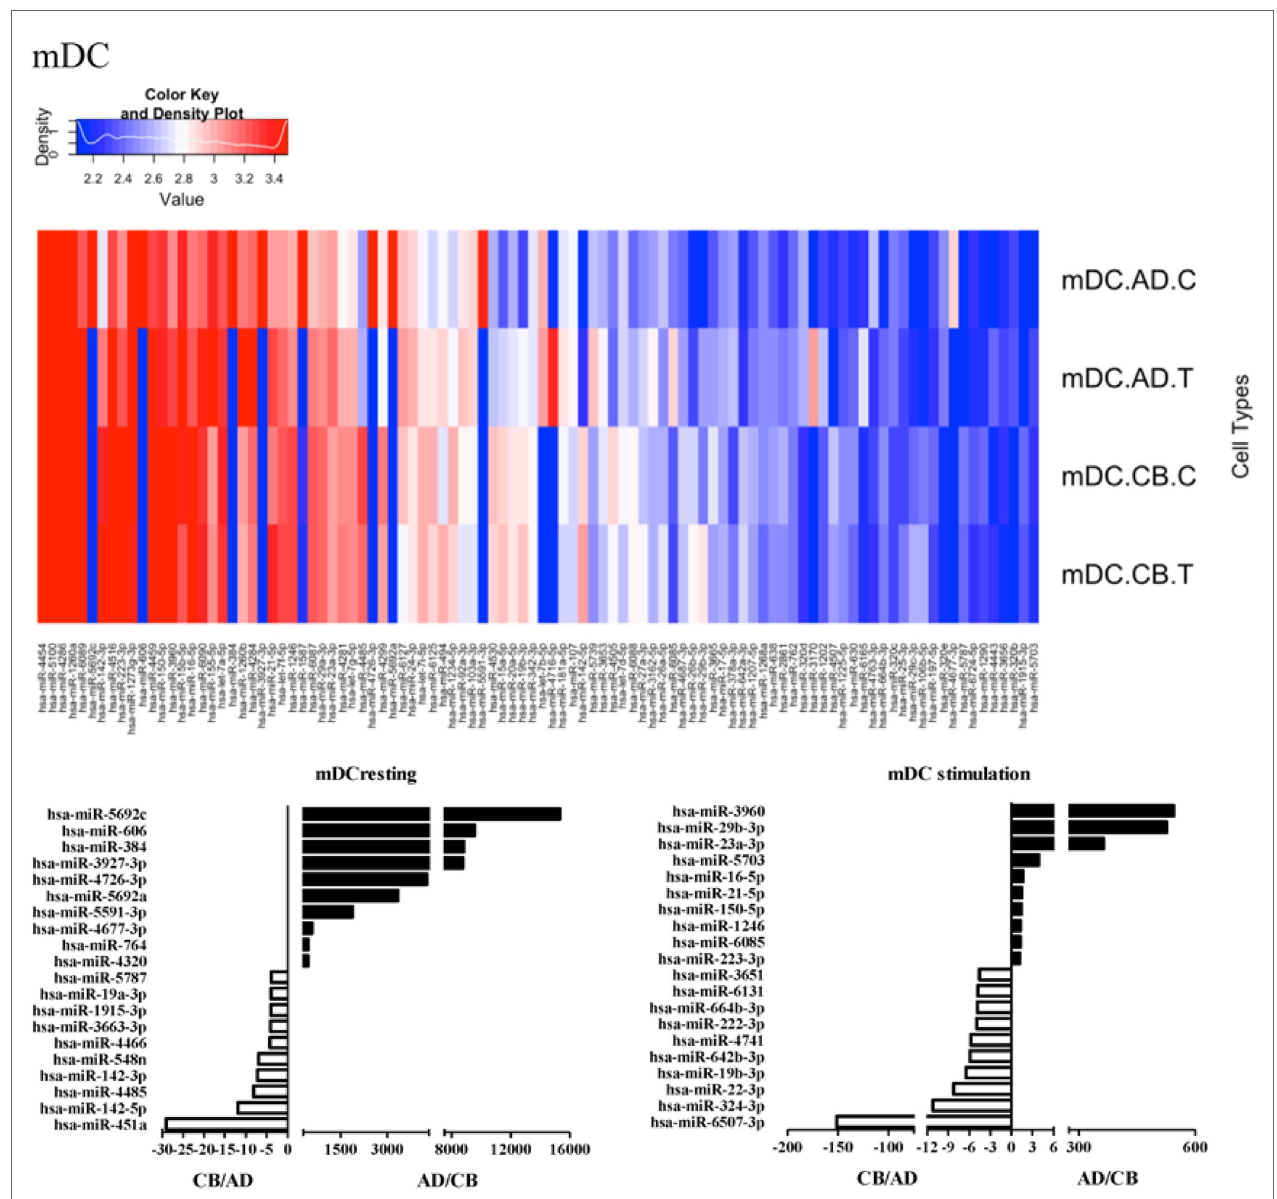
FigUre 9 | Differential microrna profiles between adult and neonatal myeloid dendritic cells